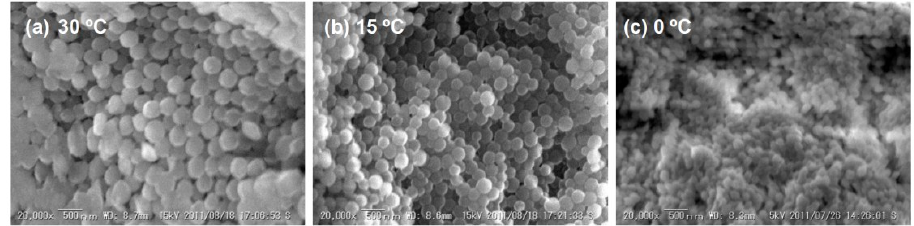
Figure 5. Effect of the polymerization temperature on the morphology of polyimide nano-particles [44].